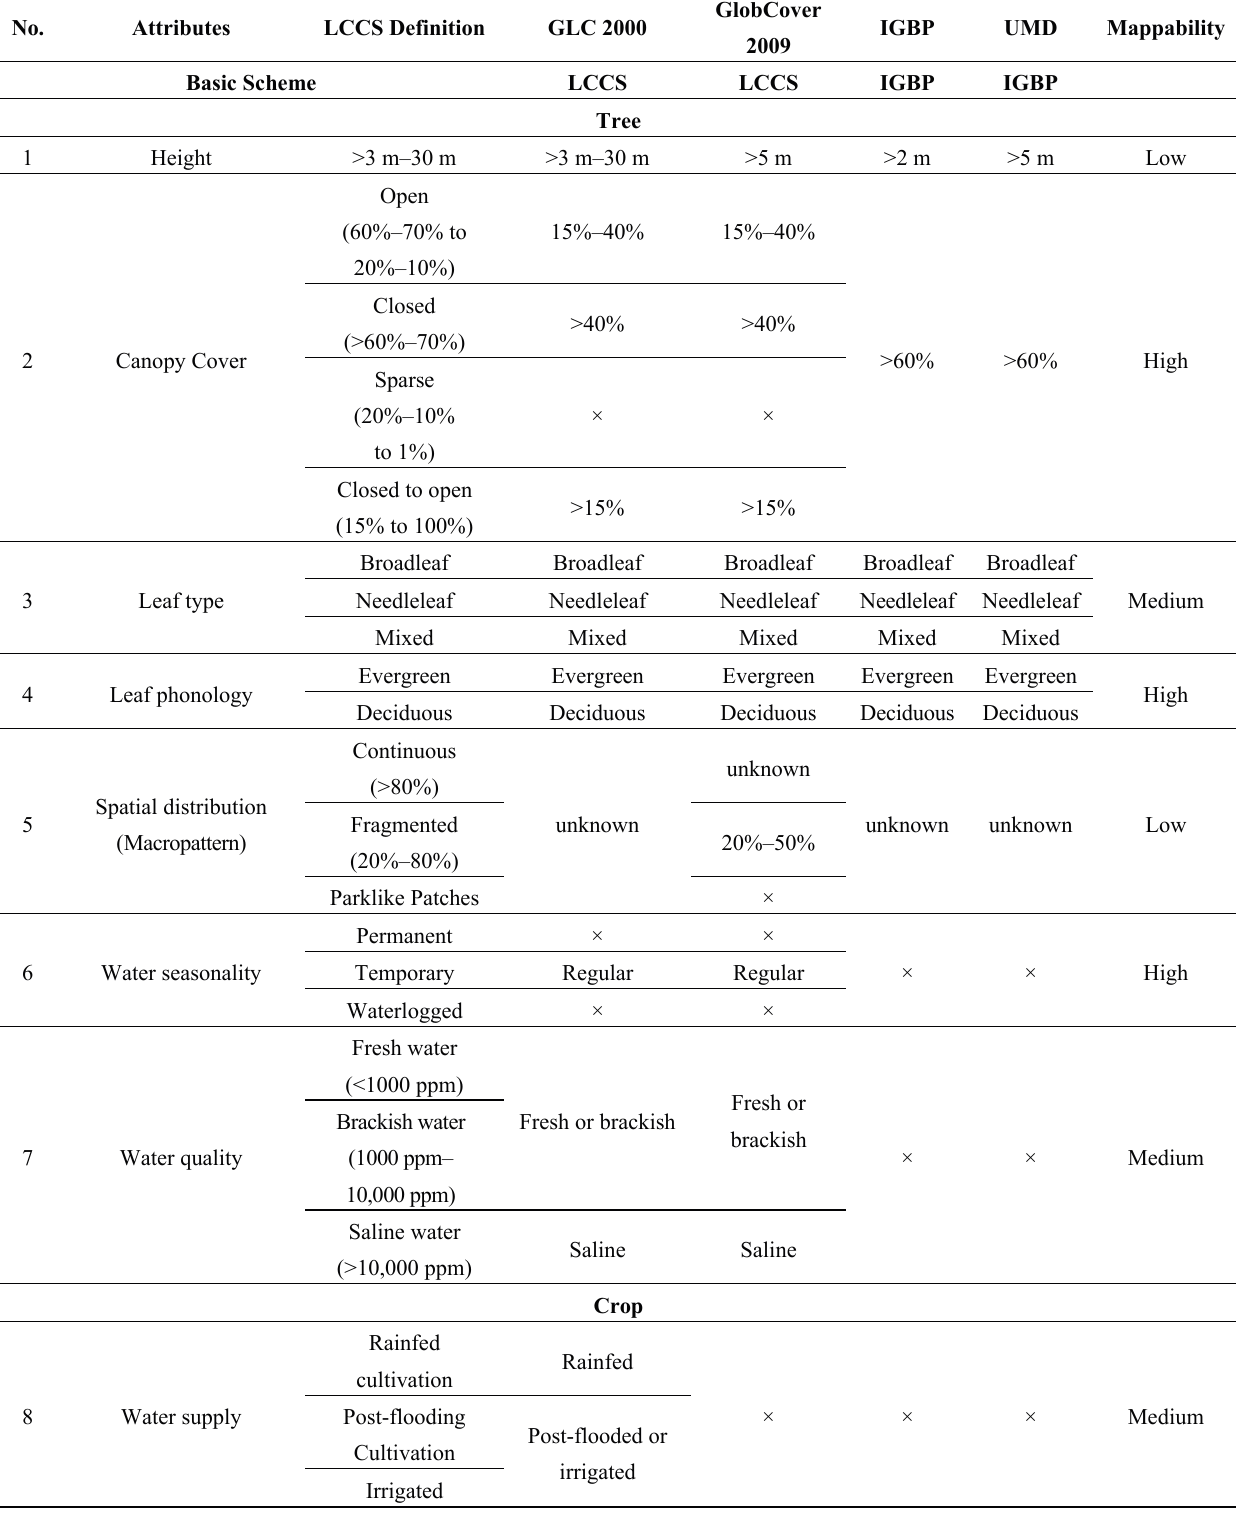
Table 5. Thresholds for the eight attributes/discriminators used in the four global land cover databases and the LCCS definition with their resulting mappability for just the forest/trees and croplands